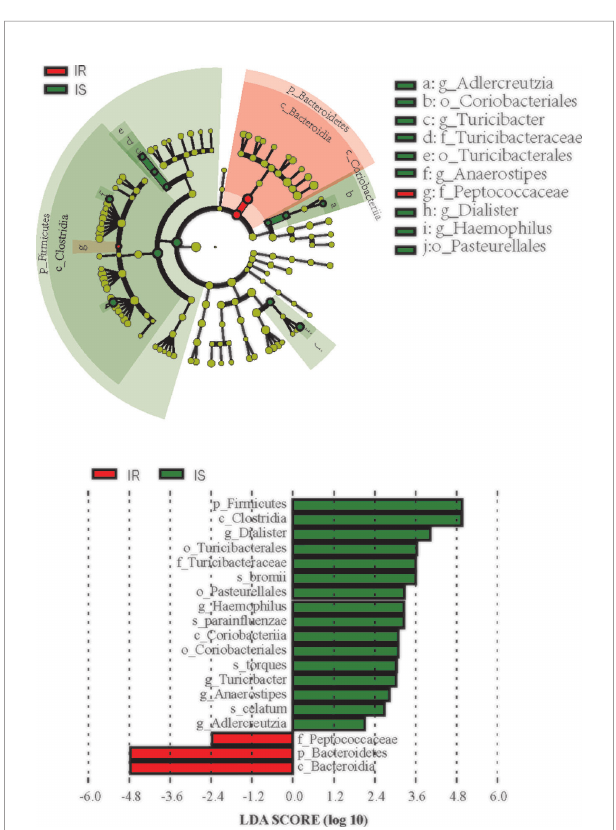
FIGURE 3 | Differential biomarkers associated with genders in IR and IS groups. A linear discriminant effect size (LeFse) analysis were performed ( a value = 0.05, logarithmic LDA score threshold =